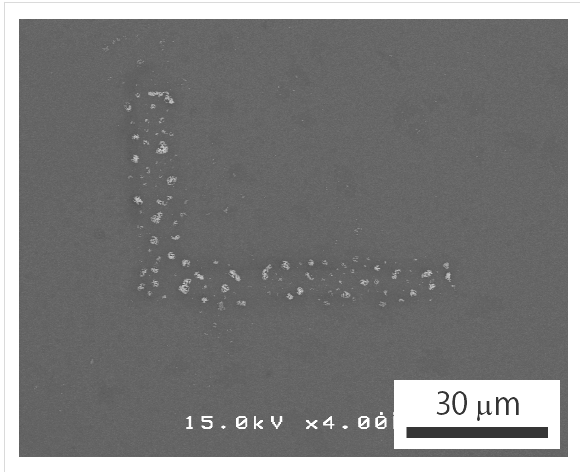
Figure 4: SEM image of the sample irradiated over a relatively large, L-shaped area.